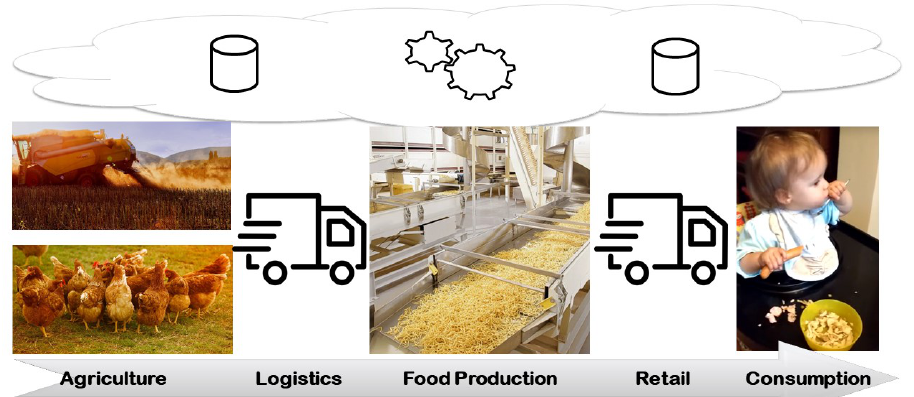
Figure 1. Overview on the different activities in the food supply chain using the example of Spätzle